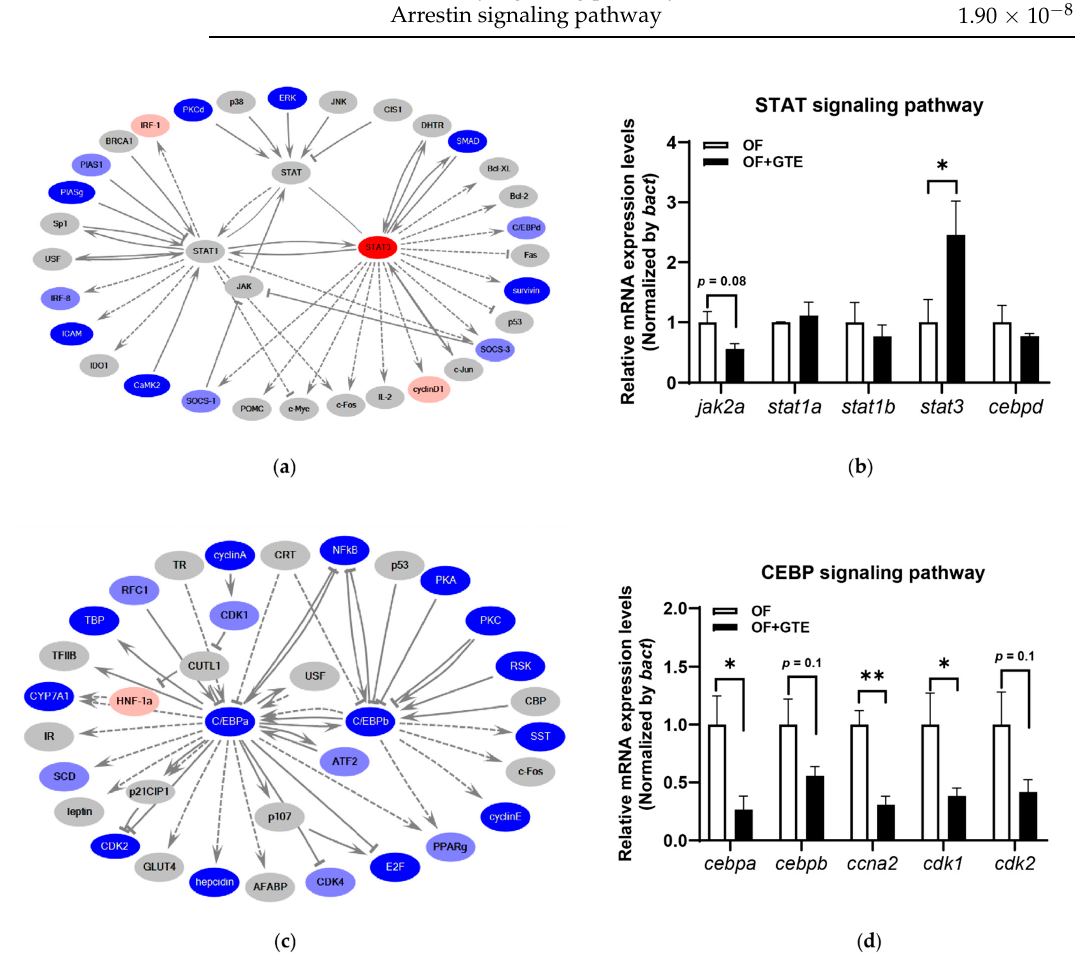
Figure 5. The supposed molecular pathways in the altered gene expression in the anti-Mibyo study. ( a ) Molecular network of transcription regulation of STAT, ( b ) selected gene expression level changes in the STAT signaling pathway, ( c ) molecular network of transcription regulation of CEBP, and ( d ) selected gene expression level changes in the CEBP signaling pathway. The red and blue colors indicate upregulated and downregulated molecules, respectively. Gray denotes genes that were not detected or statistically cut off in the RNA-seq assay. * p < 0.05, ** p < 0.01 vs. OF group, n = 4. Error bars indicate the standard deviation (SD). STAT, signal transducer and activator of transcription; CEBP, CCAAT enhancer-binding protein.